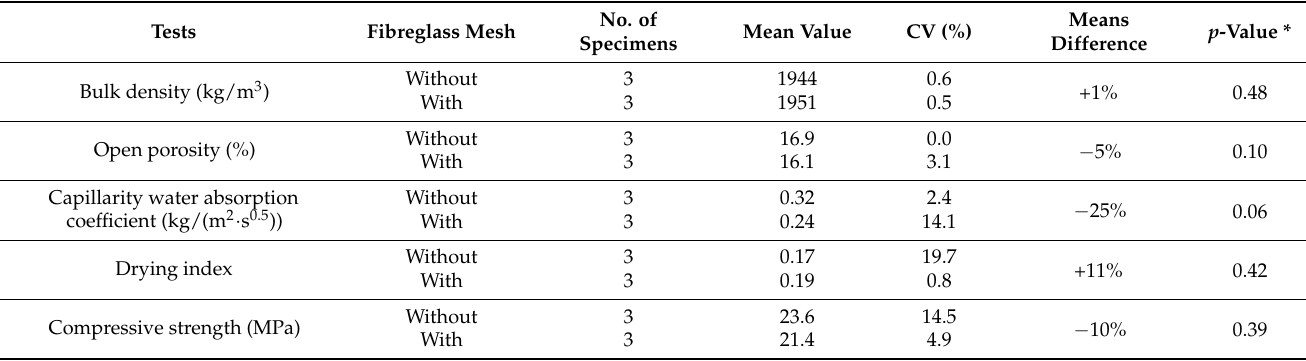
Table 2. Cement mortar applied to the hollow ceramic brick substrate.